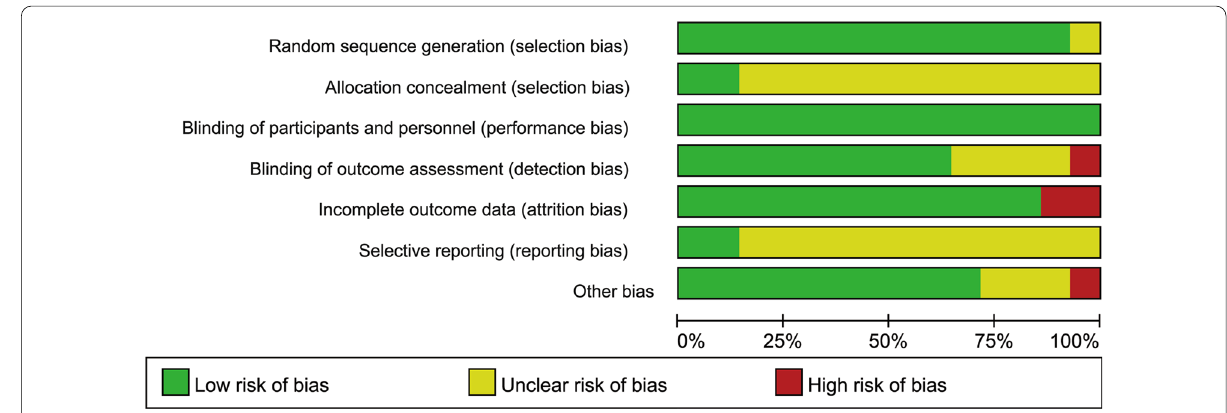
Fig. 2 Bias items presented as percentages across all included